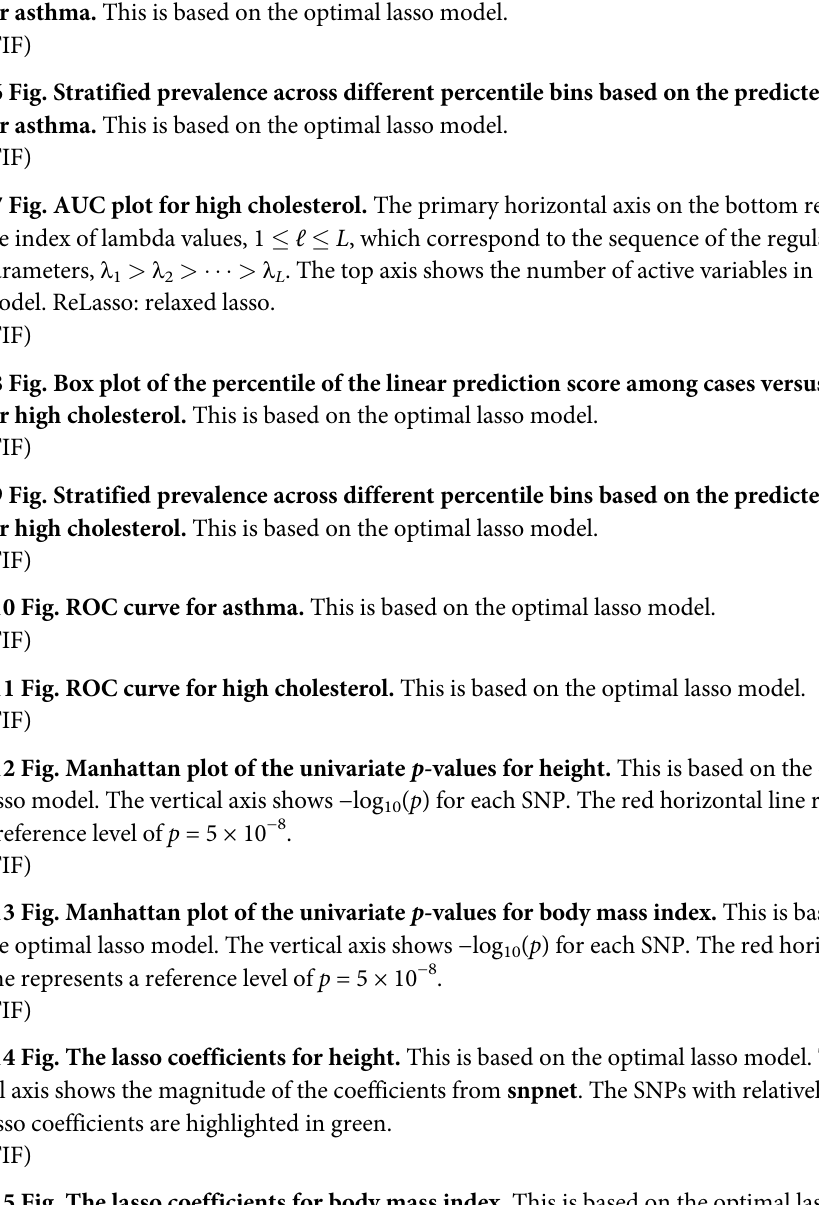
S5 Fig. Box plot of the percentile of the linear prediction score among cases versus controls for asthma. This is based on the optimal lasso model. S6 Fig. Stratified prevalence across different percentile bins based on the predicted scores for asthma. This is based on the optimal lasso model. S7 Fig. AUC plot for high cholesterol. The primary horizontal axis on the bottom represents the index of lambda values, 1 � ℓ � L , which correspond to the sequence of the regularization parameters, λ > λ > � � � > λ . The top axis shows the number of active variables in the 1 2 L model. ReLasso: relaxed lasso. S8 Fig. Box plot of the percentile of the linear prediction score among cases versus controls for high cholesterol. This is based on the optimal lasso model. S9 Fig. Stratified prevalence across different percentile bins based on the predicted scores for high cholesterol. This is based on the optimal lasso model. S10 Fig. ROC curve for asthma. This is based on the optimal lasso model. S11 Fig. ROC curve for high cholesterol. This is based on the optimal lasso model. (TIF) S12 Fig. Manhattan plot of the univariate p -values for height. This is based on the optimal lasso model. The vertical axis shows − log ( p ) for each SNP. The red horizontal line represents 10 a reference level of p = 5 × 10 − 8 . S13 Fig. Manhattan plot of the univariate p -values for body mass index. This is based on the optimal lasso model. The vertical axis shows − log ( p ) for each SNP. The red horizontal 10 line represents a reference level of p = 5 × 10 − 8 . S14 Fig. The lasso coefficients for height. This is based on the optimal lasso model. The verti- cal axis shows the magnitude of the coefficients from snpnet . The SNPs with relatively large lasso coefficients are highlighted in green. S15 Fig. The lasso coefficients for body mass index. This is based on the optimal lasso model. The vertical axis shows the magnitude of the coefficients from snpnet . The SNPs with relatively large lasso coefficients are highlighted in green. S16 Fig. Manhattan plot of the univariate p -values for asthma. This is based on the optimal lasso model. The vertical axis shows − log ( p ) for each SNP. The red horizontal line represents 10 a reference level of p = 5 × 10 − 8